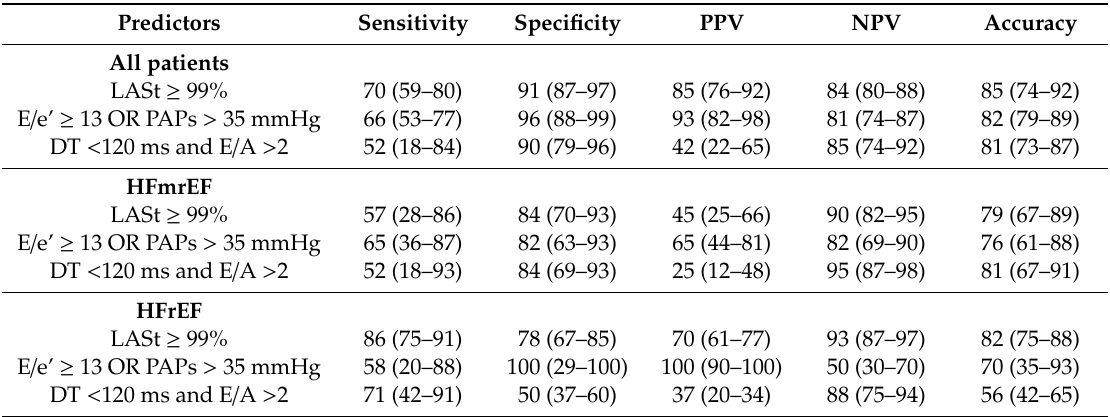
Table 3. Diagnostic accuracy of echocardiographic parameters in predicting CE in HF